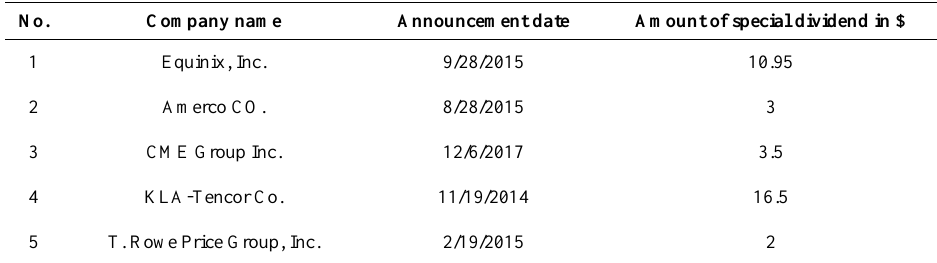
Table 1. Dividend history for five selected